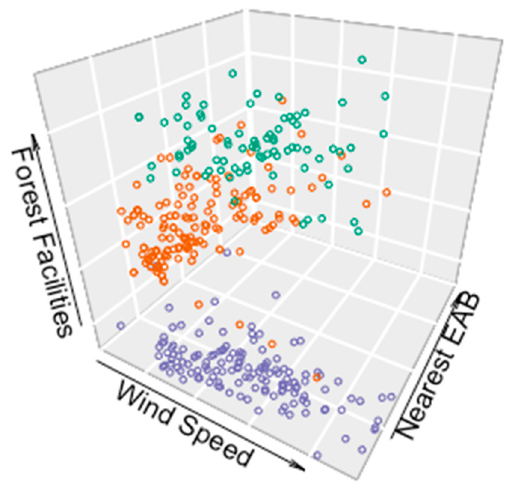
Figure 2. 3D plot of the data from three distinct counties and cities: KA: Kawartha Lakes (green dots); LE: Lennox and Addington (orange dots); WT: Waterloo (blue dots) for three predicting variables, wind speed (x-axis), nearest EAB (y-axis) and distance to forest facilities (z-axis).